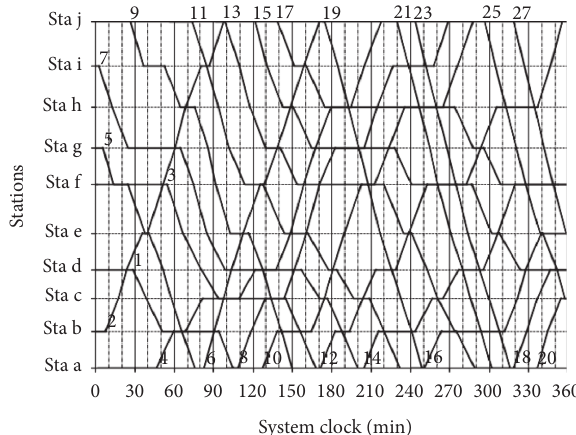
Figure 7: The arrival time and departure time in original